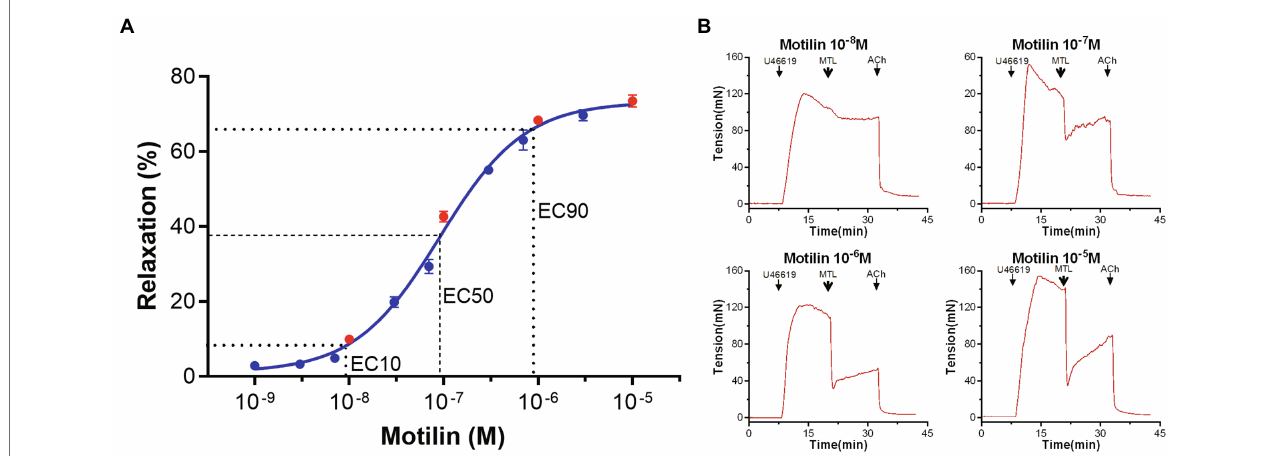
FIGURE 1 | Concentration-response curve of motilin-induced relaxation of LGA and representative traces. (A) Motilin induces LGA relaxation in dogs in a concentration-dependent manner. Values are means ± SEM ( n = 7). The dotted line shows the EC 10 , EC 50 , and EC 90 on the concentration-response curve. (B) Motilin concentrations in the traces correspond to the red dots in panel (A) . The arrows indicate the time of drug administration. ACh, acetylcholine; EC, effective concentration; LGA, left gastric artery; MTL, motilin; and SEM, standard error of the mean; U46619, thromboxane A 2 receptor